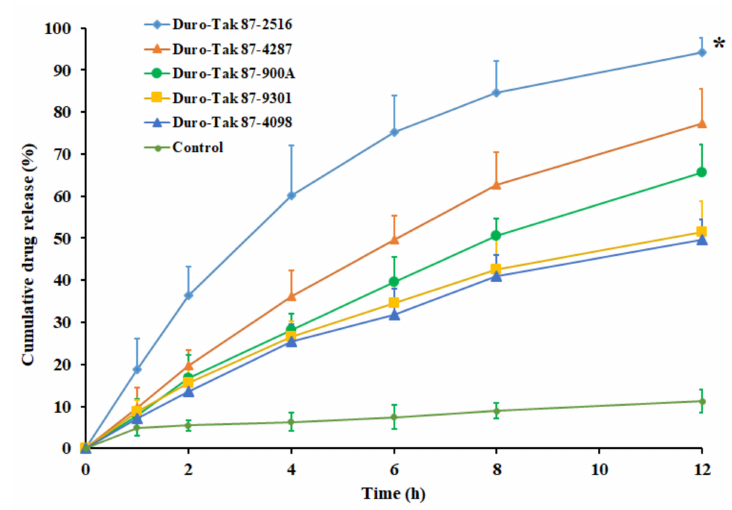
Figure 1. Comparison of the percentage of pioglitazone released at various time intervals from DIA pioglitazone (2% w / w ) patch prepared using various adhesives. All values are mean ± SD ( n = 6). The profile of DIA patch prepared using Duro-Tak 87-2516 adhesive is statistically (*) di ff erent ( p < 0.001) when compared to other adhesives